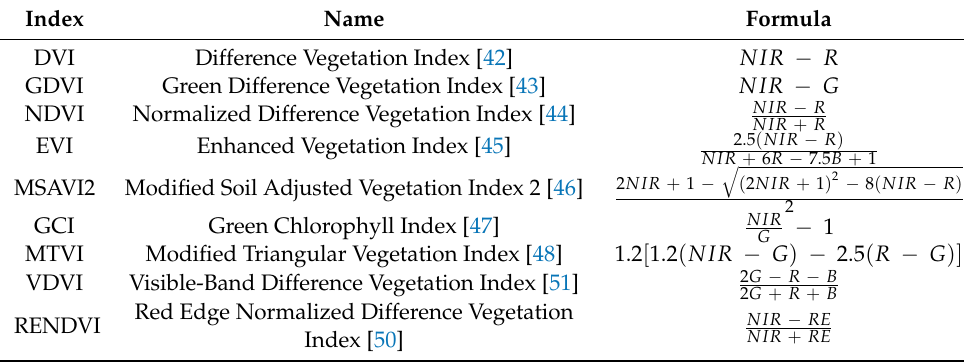
Table 3. Select vegetation indices used in this